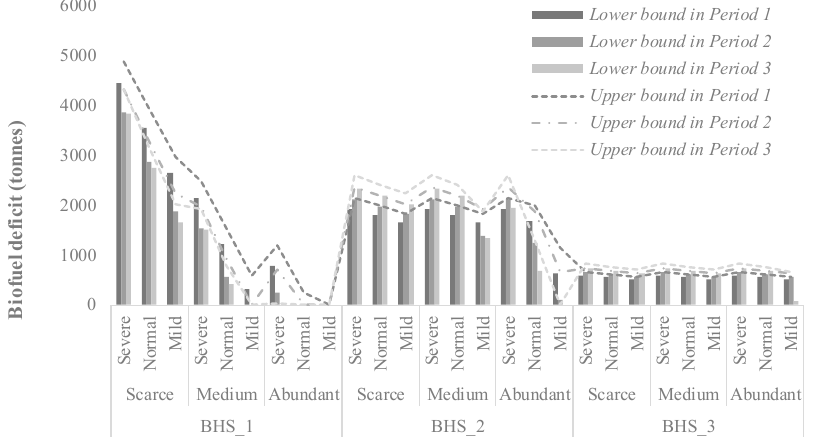
Figure 4. Biofuel deficit variation trend of different BPHSs under various scenario combinations at α = 0.5 and Pr = 0.01.